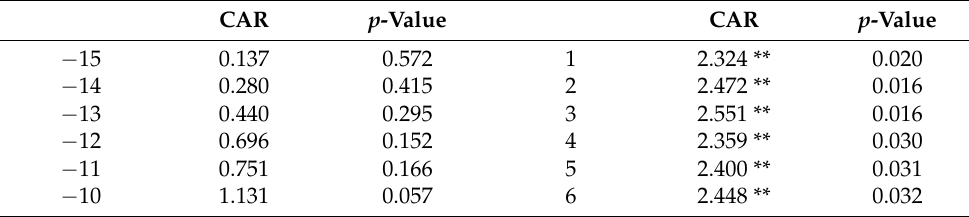
Table 2. CAR of IC design houses in patent